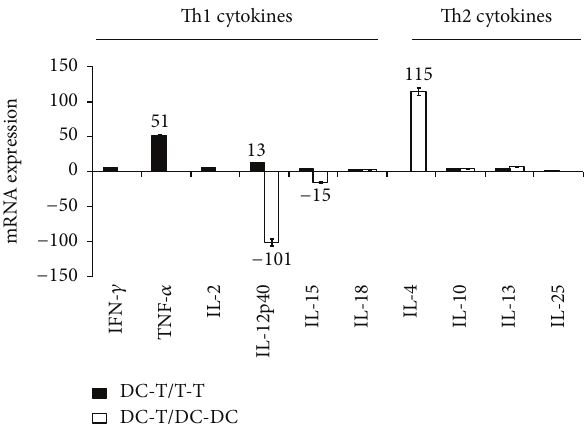
Figure 1: cDNAs generated from DC-DC hybrid cells (DC-DC), D5lacZ tumor cell hybrids (T-T), and DC-tumor cell hybrids were subjected to quantitative real-time PCR analyses using primer pairs which detect the Th1 cytokines IFN- 𝛾 , TNF- 𝛼 , IL-2, IL-12p40, IL- 15, and IL18 and the Th2 cytokines IL-4, IL-10, IL-13, and IL-25. Samples were run in duplicate and difference in mRNA expression was calculated using the ΔΔ Ct method. Error bars represent the standard error of the mean. One representative experiment out of three independent experiments is